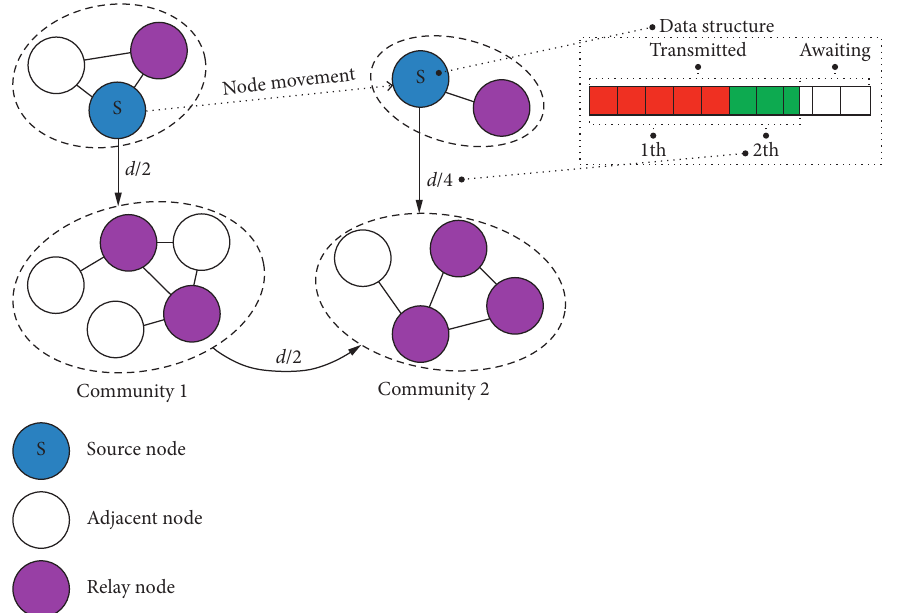
Figure 5: Information delivery and data structure in second-time transmission.